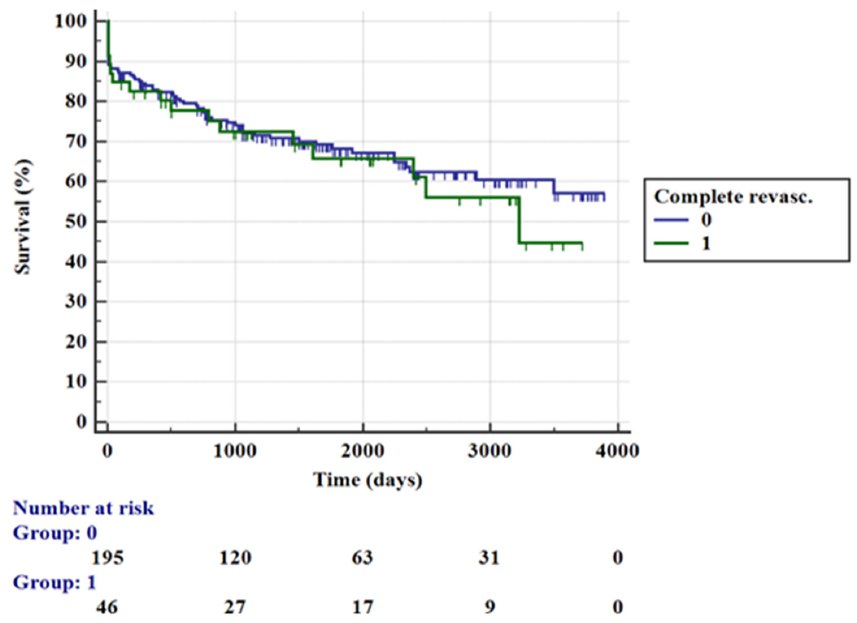
Figure 3. Kaplan–Meier curves for mortality rate in multivessel coronary artery disease group according to PCI strategy.